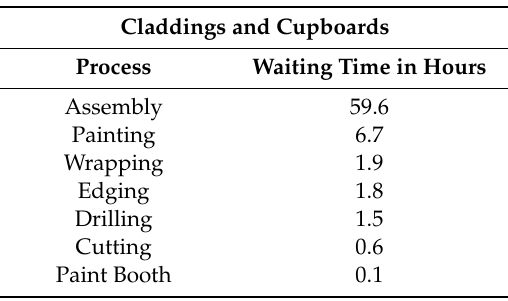
Table 8. Processes Waiting-Time.